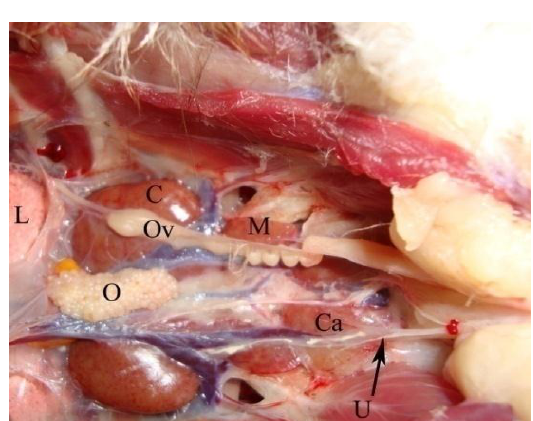
Fig. 2: photograph illustrates anatomical position (ventral view).